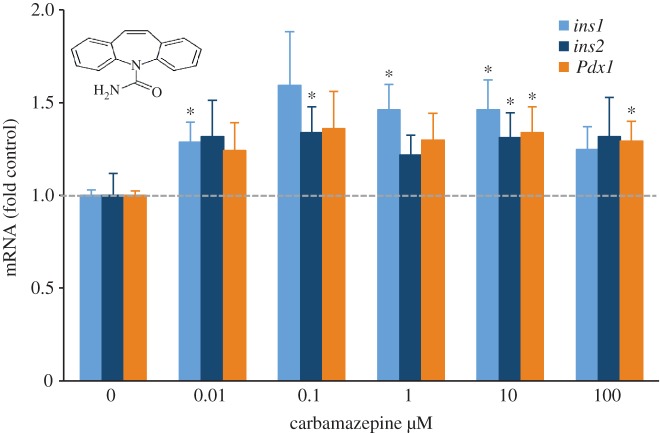
Dose–response profile of carbamazepine on insulin gene expression in primary mouse islets. After 24 h of carbamazepine treatment, Ins1, Ins2 and Pdx1 gene expression were quantified with qRT-PCR relative to DMSO controls in primary mouse islets (n=7). *p<0.05.